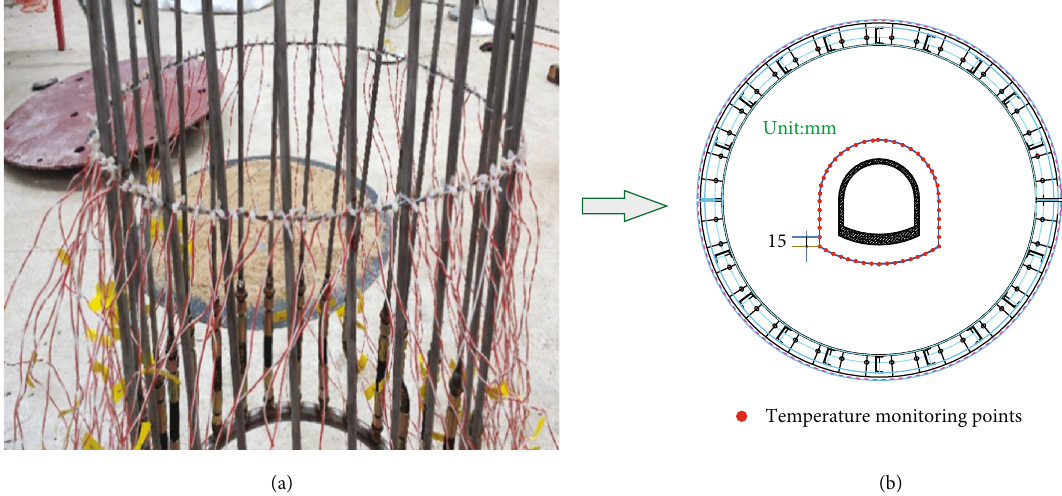
Figure 7: Circumferential temperature measurement arrangement: (a) Site photo and (b) Schematic diagram of speci fi c